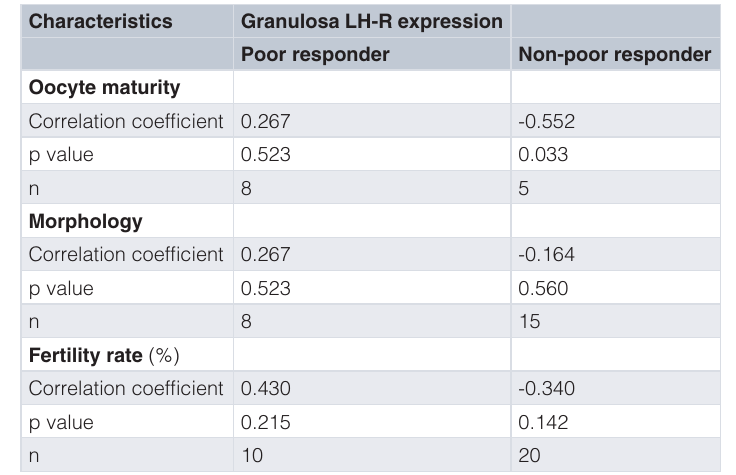
Table 4. Correlation between granulosa LH-R expression with maturity, oocyte morphology, and fertility rate of poor and non-poor responders